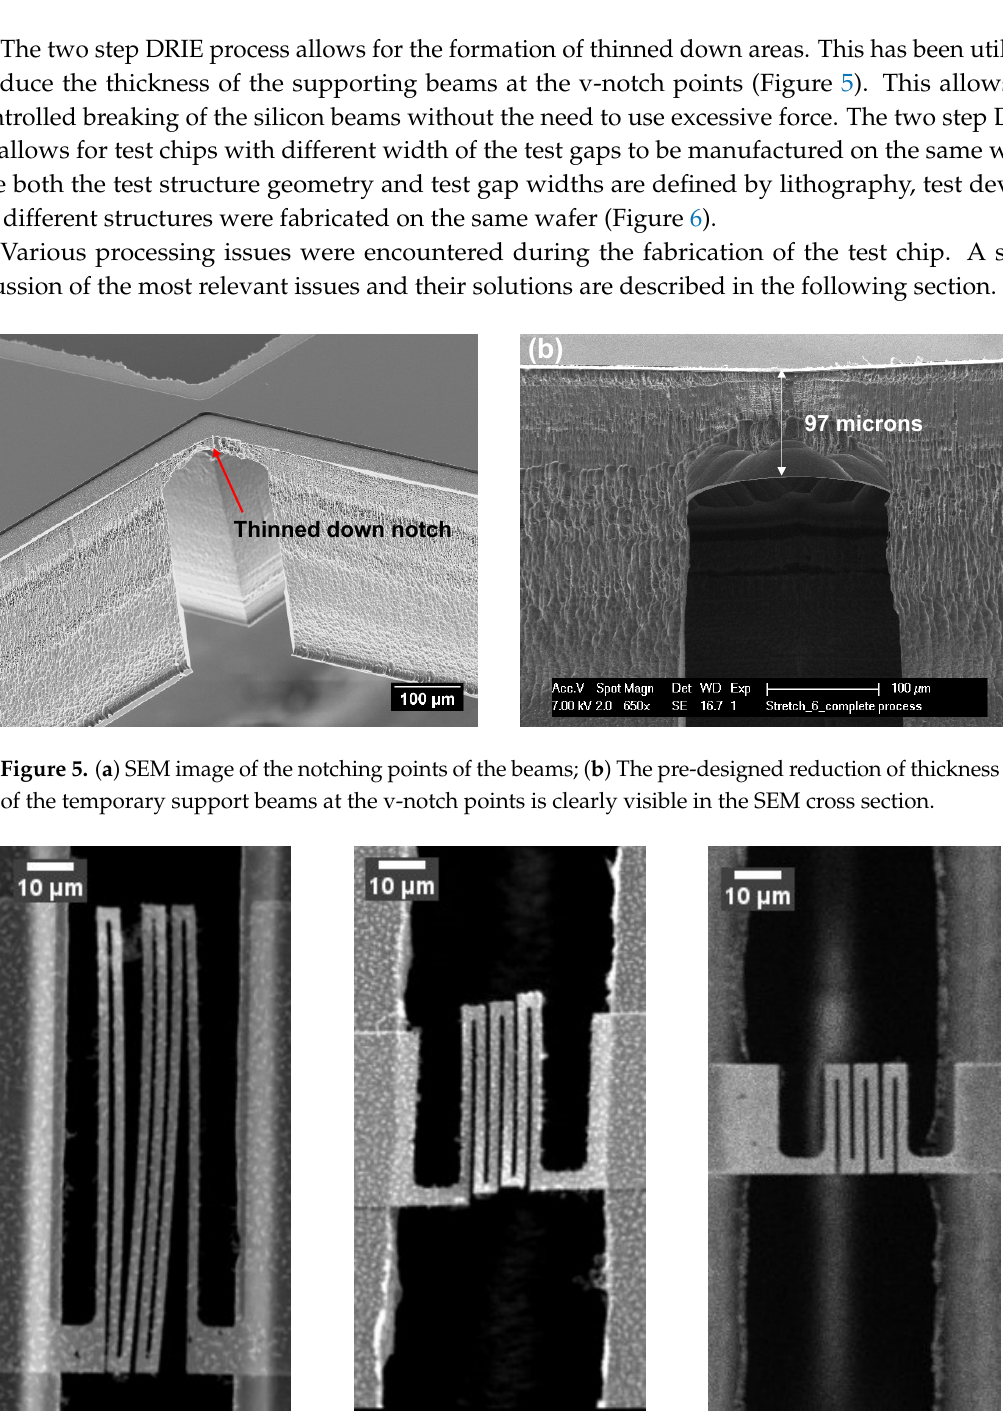
Figure 6. SEM pictures showing free standing test structures with different dimensions spanning a 50 µ m test gap fabricated on the same substrate. The picture demonstrates that different test structures can be fabricated on the same substrate using the same fabrication